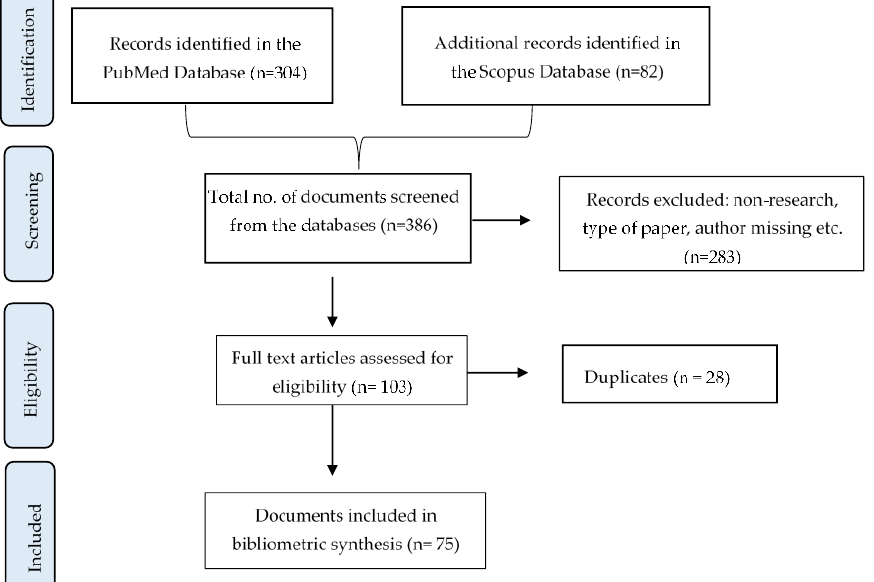
Figure 1. Flowchart indicating included and excluded articles.